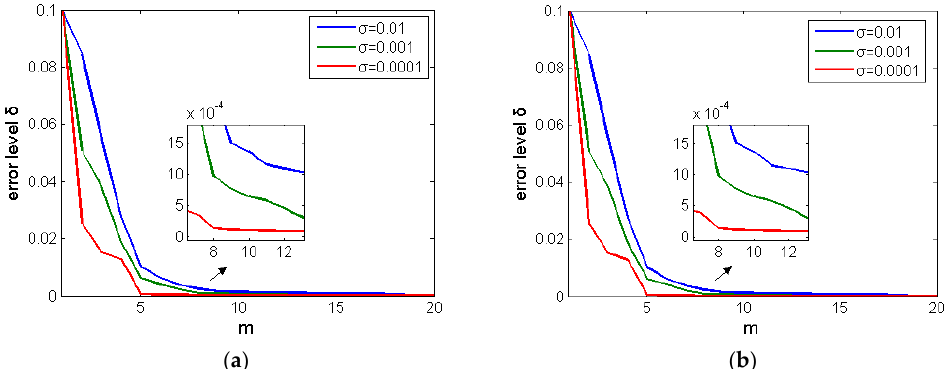
Figure 6. Attenuation of δ with the gradual increase of m when σ is 0.01, 0.001 and 0.0001: ( a ) butt-welded signal and ( b ) ball-welded signal.